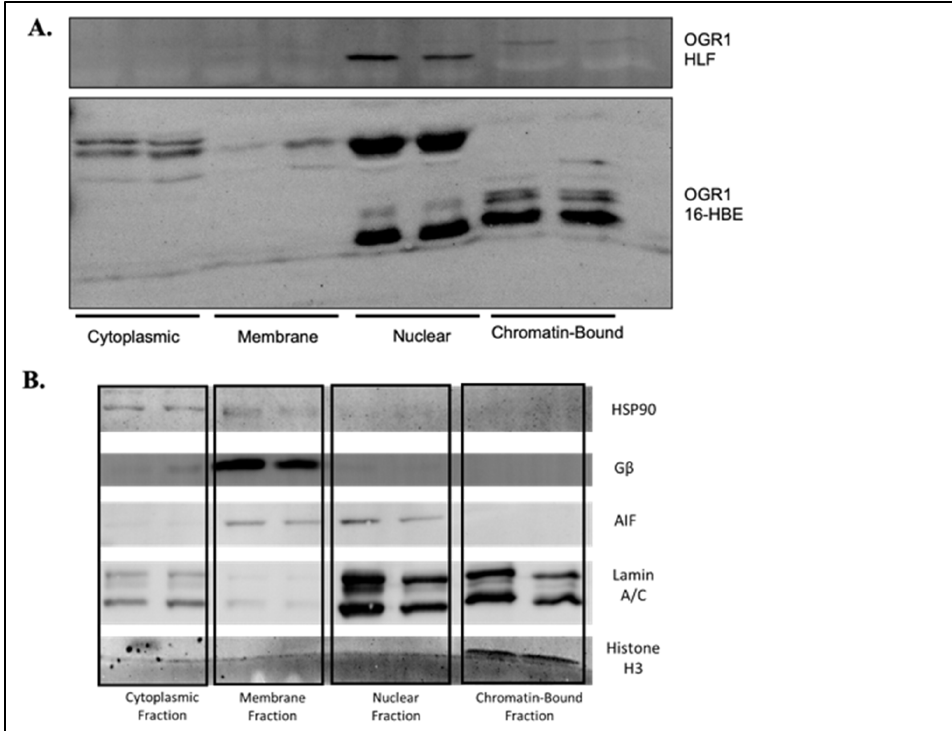
Figure 9. OGR1 has cell-type-specific subcellular localization. Fibroblasts and 16-HBE cells were subjected to subcellular fractionation, and western blot was performed to assess where OGR1 was located. Representative western blots are displayed with duplicate samples per fraction. In fibroblasts, OGR1 was selectively located in the nuclear fraction ( A , upper panel). However, in 16-HBE cells, OGR1 was in the cytoplasmic, nuclear, and chromatin-bound fractions; to a lesser degree, OGR1 was in the membrane-bound fraction ( A , lower panel). Treatment with TGF- β did not cause translocation to different subcellular fractions (data not shown). The purity of subcellular fractions was verified by the markers shown ( B ). The unique location of OGR1 in different cell types may explain some of the functional and signaling differences observed between 16-HBE and fibroblasts.